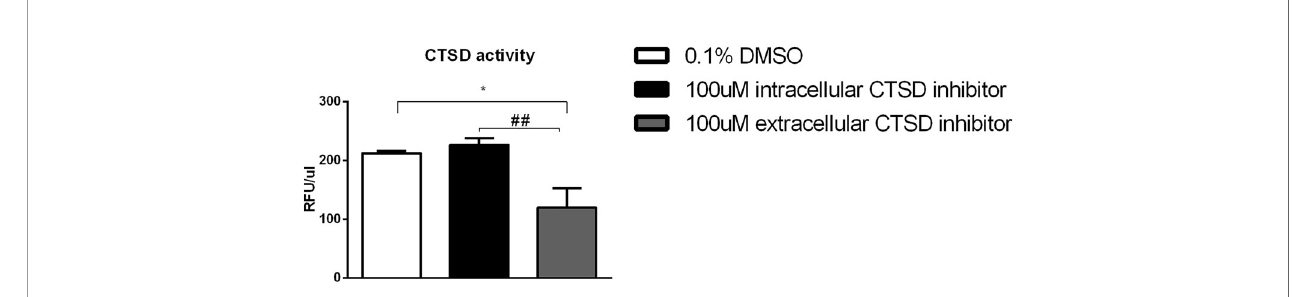
FIGURE 1 | Ef fi cacy of the cathepsin inhibitors: CTSD activity measurements from the supernatant of the Wt mouse BMDMs, exposed to 24 hours and subsequently treated with either vehicle control (0.1% DMSO) or 100µM CTSD inhibitors for 4 hours. Error bars represent ± SEM; n = 5 from two independent experiments. * represents p < 0.05 compared to DMSO-treated BMDMs. ## represents p < 0.01 compared to intracellular CTSD inhibitor- treated BMDMs by means of one-way